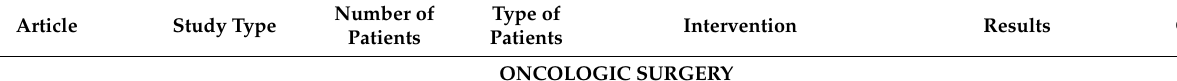
Table 2. Summary of the evidence obtained based on the search strategy and selection of articles with evidence rating using GRADEpro for general oncological surgery. IN: immunonutrition; PO: postoperative; UTI: urinary tract